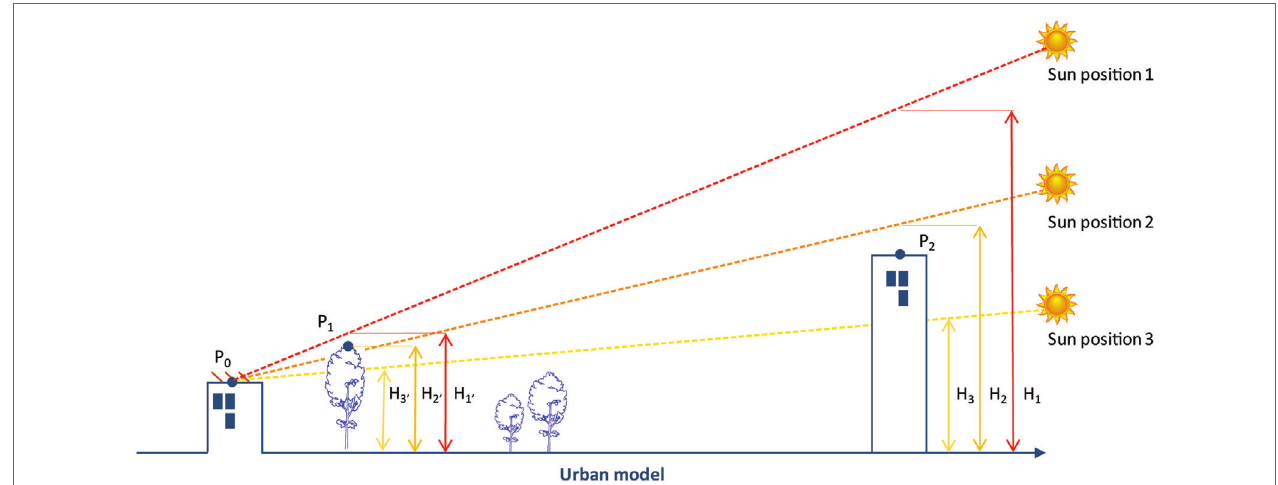
FIGURe 3 | Principle of the shadow casting algorithm, adapted with permission from © 2018 Springler (Desthieux et al., 2018).